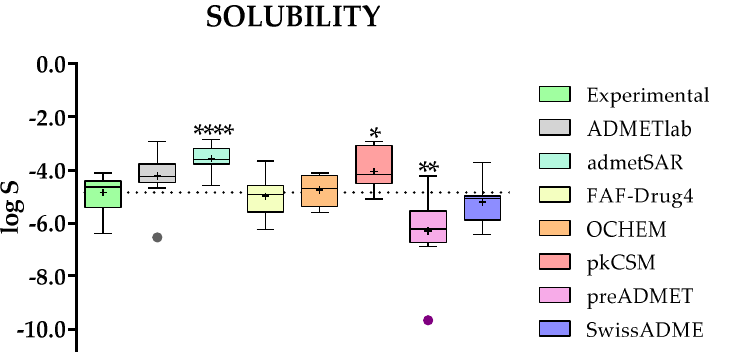
Figure 3. Comparison of the experimental and predicted data for solubility (log S) between ADMETlab, admetSAR, FAF-Drug4, OCHEM, pkCSM, preADMET, and SwissADME. Statistical analysis was performed by a pairwise t -test ( n = 11, * p ≤ 0.05, ** p ≤ 0.01, *** p ≤ 0.001 and **** p ≤ 0.0001) versus experimental data.